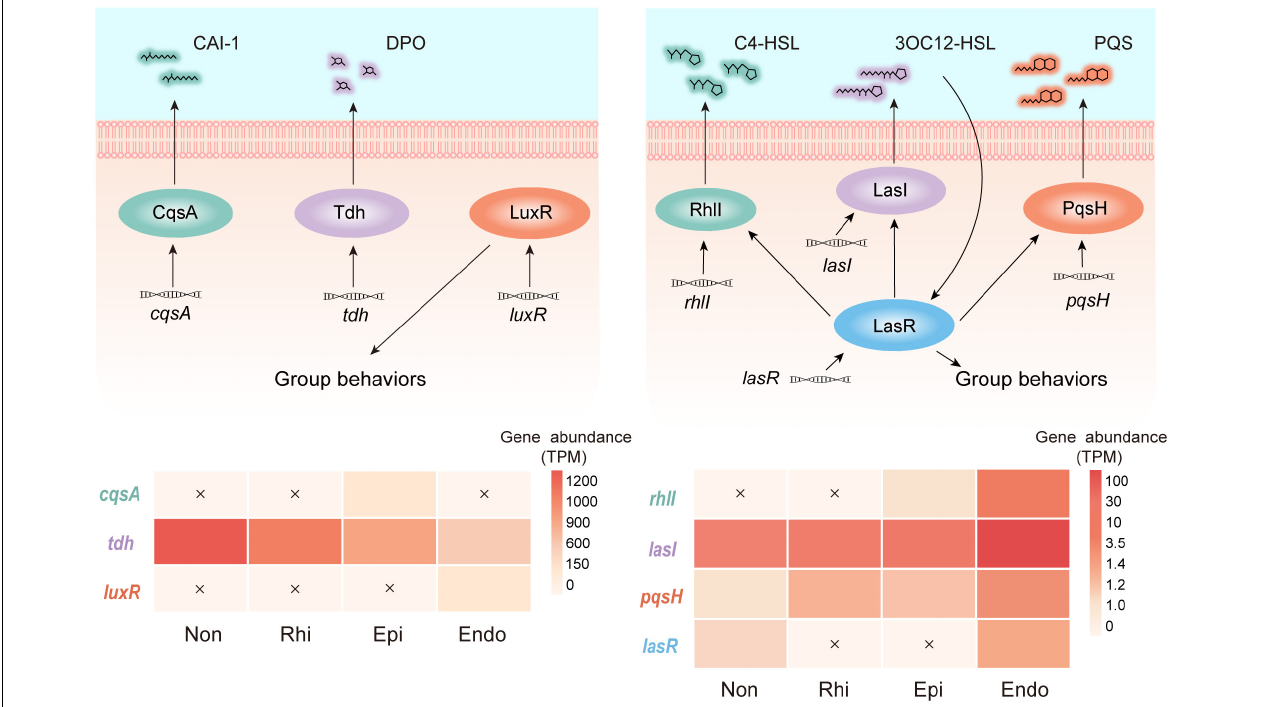
FIGURE 3 | Profiles of two quorum sensing modules across the non-rhizosphere (Non), rhizosphere (Rhi), episphere (Epi) and endosphere (Endo) compartments. In module 1, cqsA and tdh encode the autoinducers (S)-3-hydroxytridecan-4-one (CAI-1) and 3,5-dimethyl-pyrazin-2-ol (DPO), respectively, and luxR mediates group behaviors. In module 2, lasI , rhlI , and pqsH encode the autoinducers N-(3-oxododecanoyl)-L-homoserine lactone (3OC12-HSL), N-butyryl-L-homoserine lactone (C4-HSL), and 2-heptyl-3-hydroxy-4-quinolone (PQS), respectively. lasR encodes the receptor of 3OC12-HSL which mediates group behaviors. The relative abundance (TPM, transcripts per-million) of genes belonging to each module across four compartments in the soil-mangrove root system is represented by heatmaps, and each undetected gene is marked with a